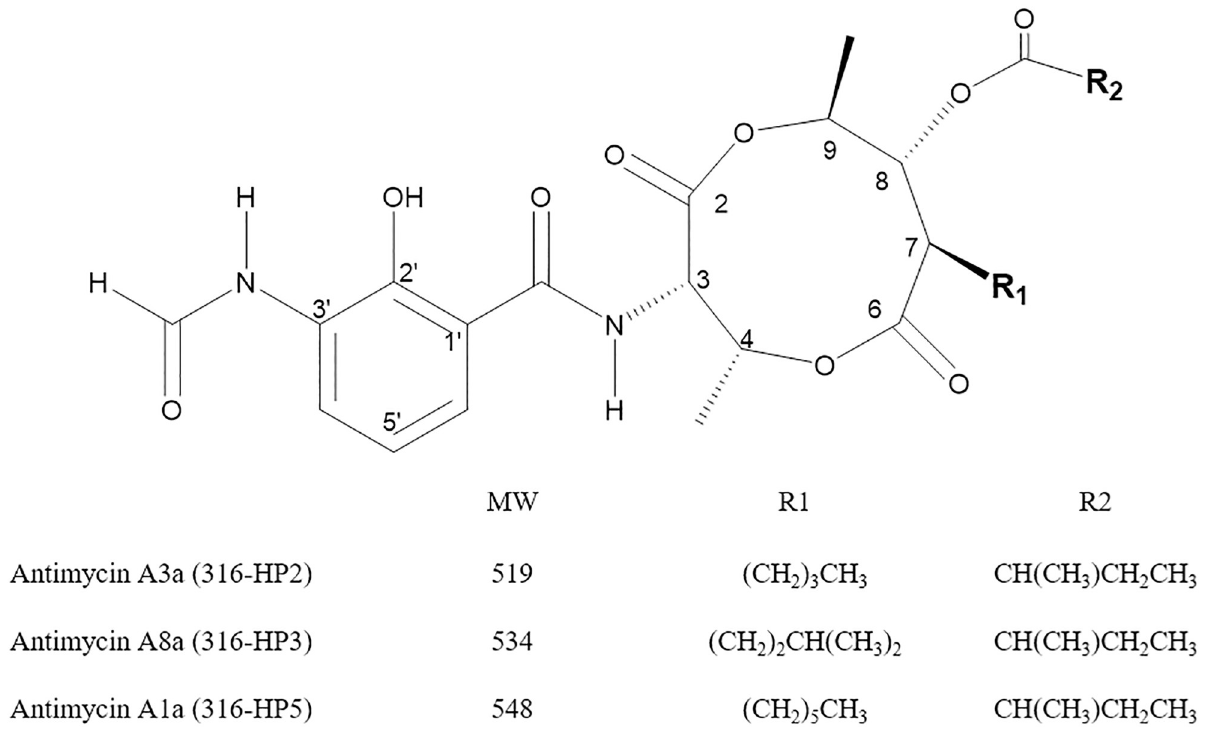
Fig 7. The structures of the antimycins purified from Streptomyces sp. KR0006.